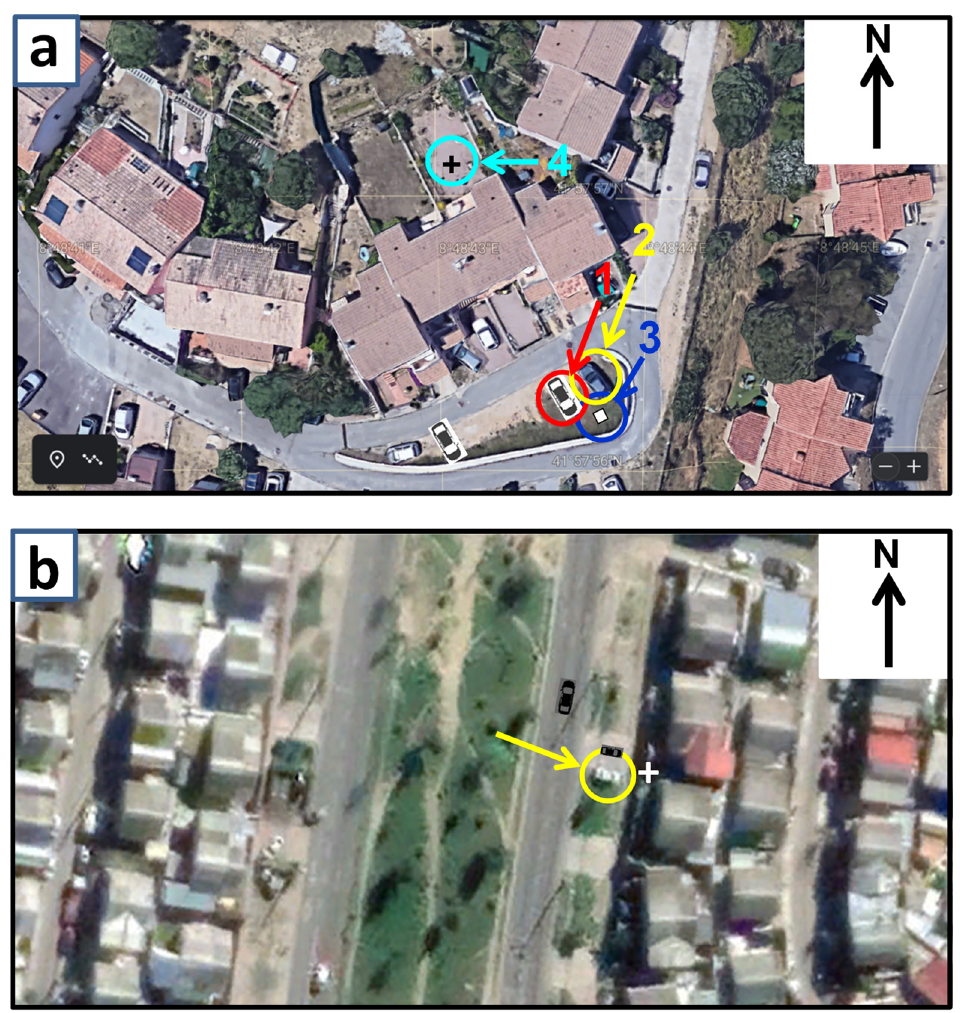
Figure 2. Experimental sites. ( a ) Ajaccio site. 1: VW and AD cars, oriented SSE; 2: nearby parked car; 3: planar condenser used as a reference; 4: meteorological station. The North direction is indicated by the black arrow. (From Google Earth, 1 October 2020). ( b ) Valparaiso. The arrow indicates the DC car location and the cross the meteo station. (From Google Earth, 1 August 2019).